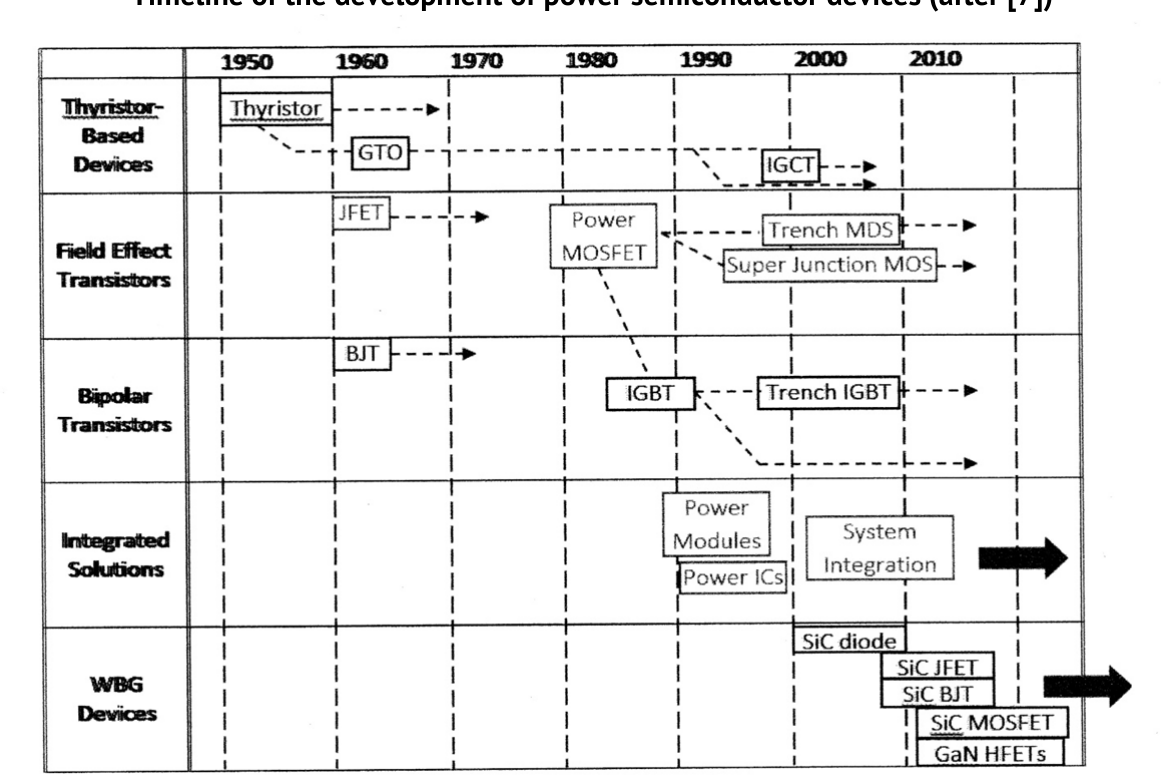
Timeline of the development of power semiconductor devices (after